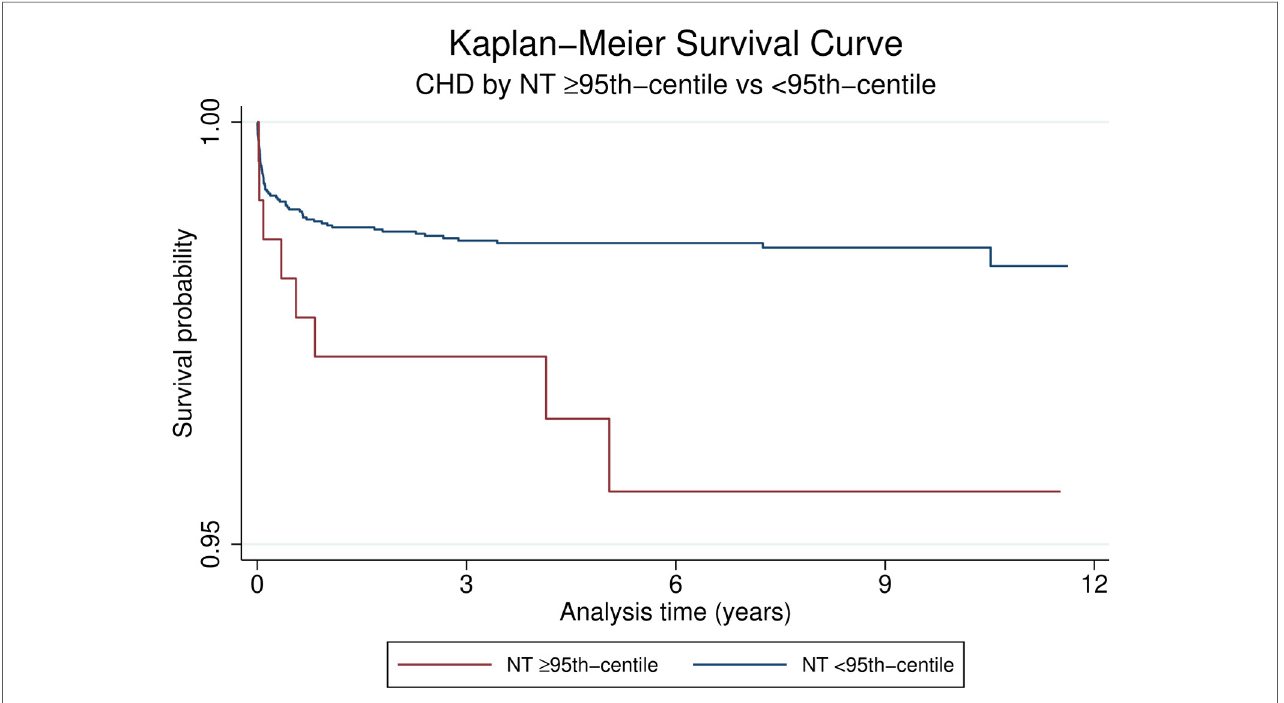
FIGURE 2 Kaplan-Meier survival curves of CHD by NT ≥ 95th centile vs. <95th Centile. Note scaled y-axis to highlight region of difference of Kaplan-Meier curves